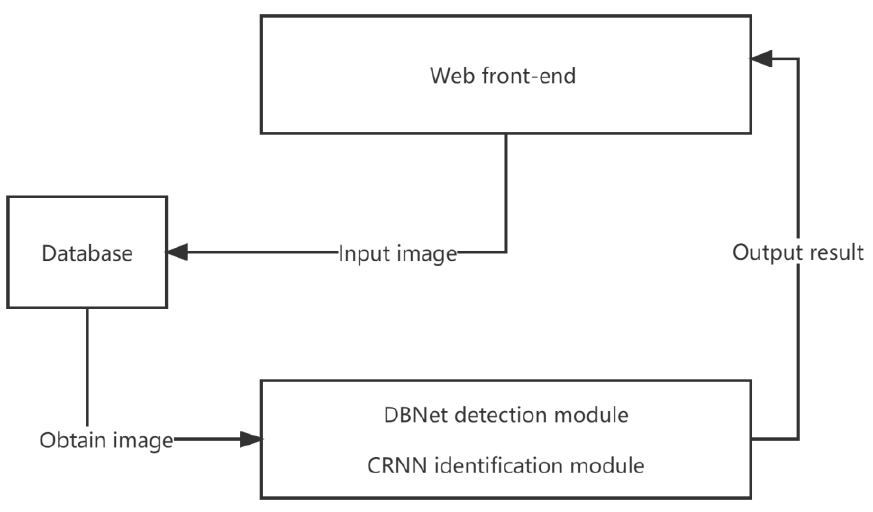
Figure 12. Flow of pill box text detection system.